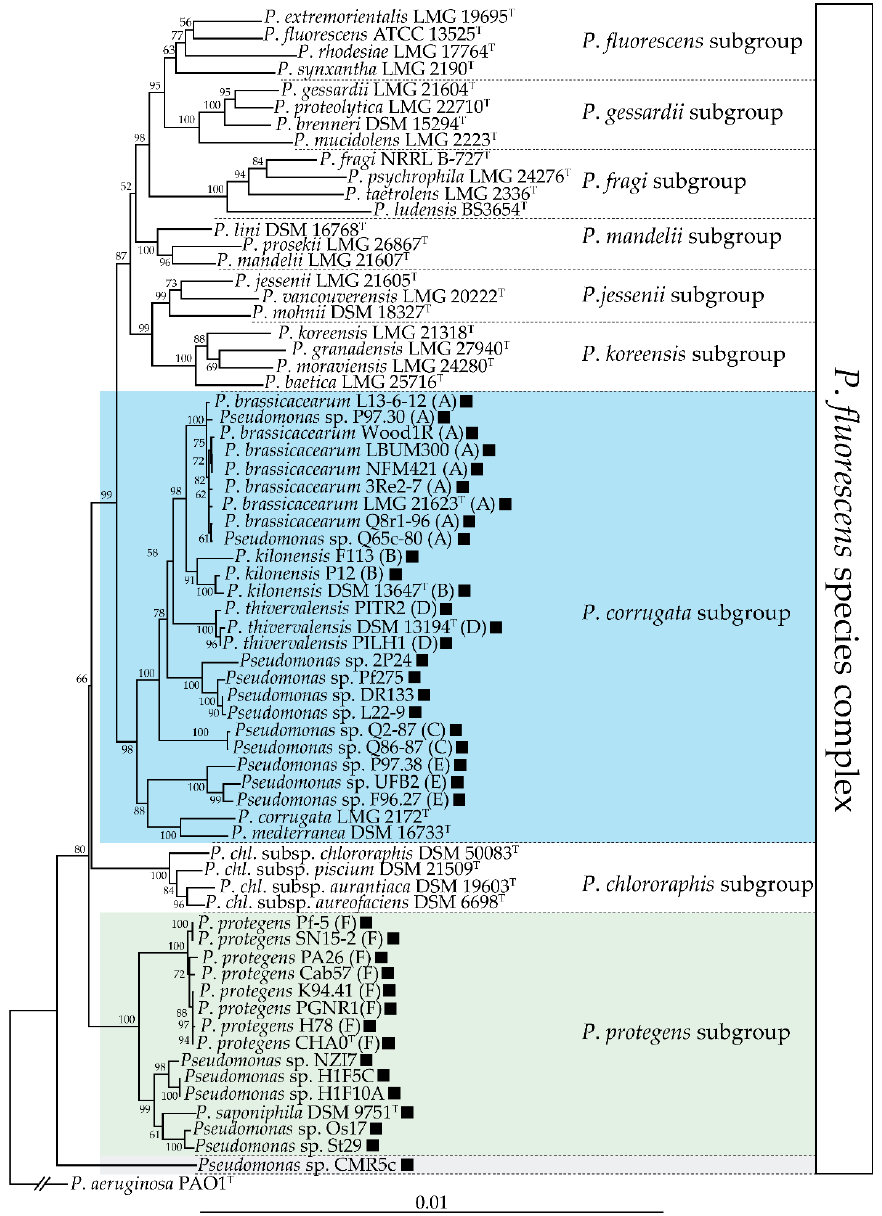
Figure 2. Distribution of the phl biosynthetic gene cluster in the P . fluorescens species complex. This neighbour-joining phylogeny is based on an alignment of the concatenated partial sequences of four housekeeping genes (16s rDNA, gyrB , rpoB , rpoD ; 2945 nucleotides total) generated using MUSCLE [33] . The phylogenetic tree was generated using PhyML [34] and the distance matrices were calculated by the Jukes-Cantor method. Bootstrap values over 50% (out of 1000 replicates) are indicated at the nodes. The presence of a black square indicates that that strain harbours the phl biosynthetic gene cluster. The three subgroups encompassing DAPG-producing strains are highlighted in color. Letters following the strain names correspond to multilocus phylogenetic groups described by Frapolli and colleagues [35] .